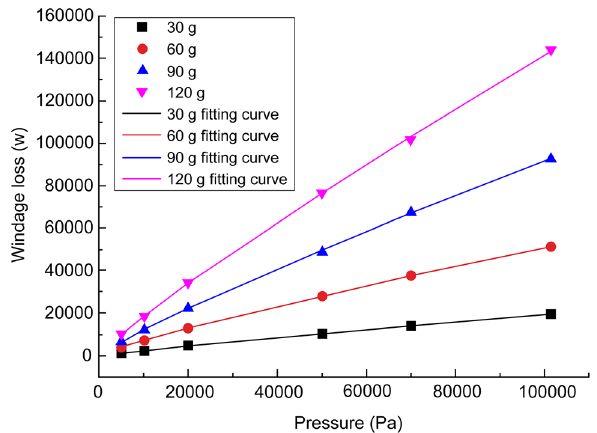
Fig. 10 Relationship between windage loss and operating pressure under different centrifugal accelerations Table 2 Fitting formulae for windage loss and operating pressure under different centrifugal accelerations Centrifugal acceleration Fitting (m/s 2 )